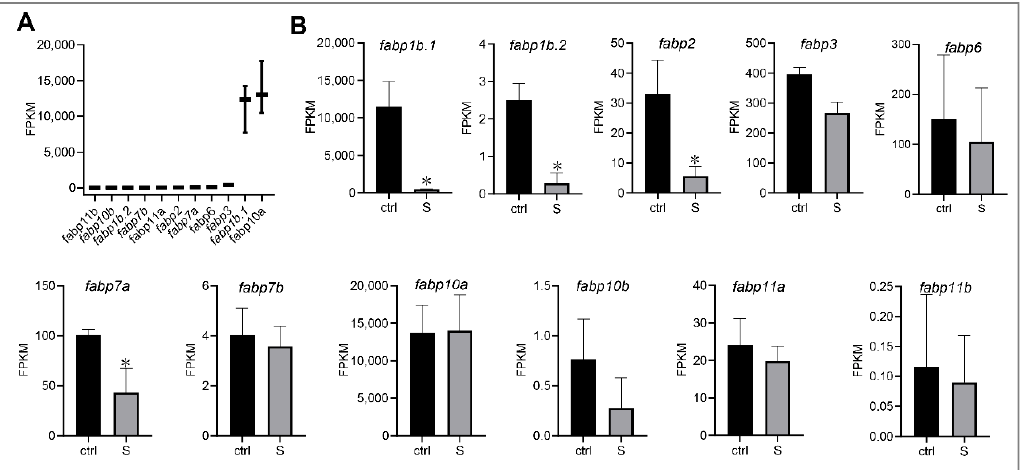
Figure 4. Effect of starvation on the gene expression involved in fatty acid binding proteins (FABPs) in liver tissues. ( A ) Gene expression of FABPs, including fabp1b.1 , fabp1b.2 , fabp2 , fabp3 , fabp6 , fabp7a , fabp7b , fabp10a , fabp10b , fabp11a , and fabp11b , were extracted in the control larvae from RNA-seq data. ( B ) Differential expression of FABP genes in the control and starved larvae. The FPKM value represents the mean ± SEM of three independent RNA-seq biological replicates. * indicates significant differences ( p < 0.05).